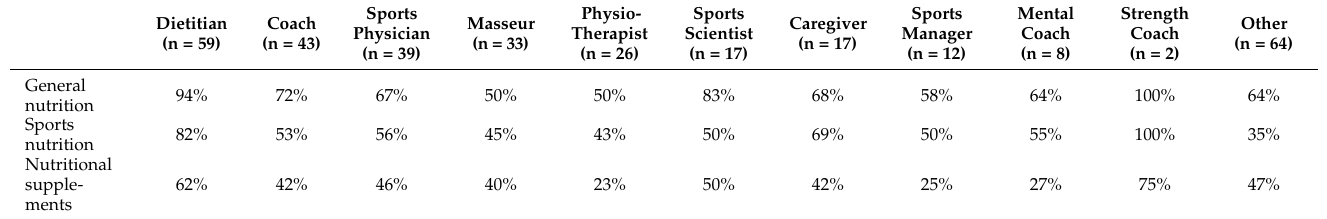
Table 5. Self-reported knowledgeability for general nutrition, sports nutrition, and nutritional supplements for each sports health